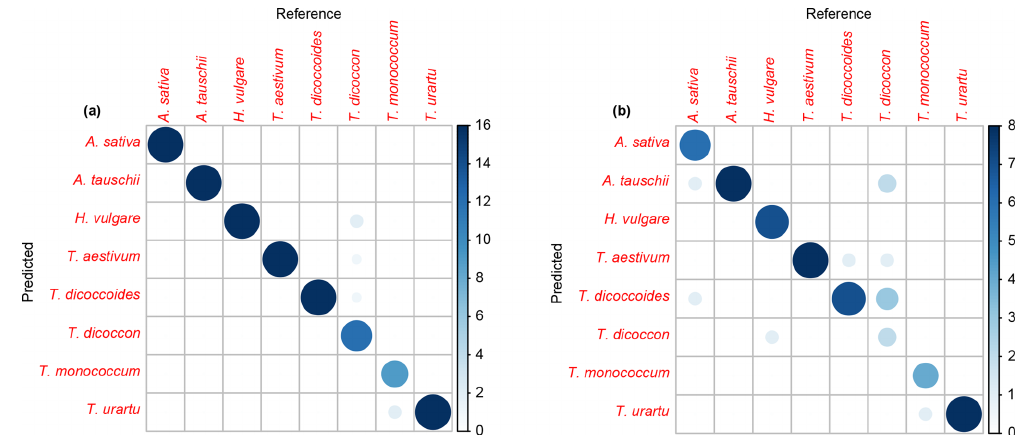
Figure 5. Confusion matrices for k -nn classification. (a) Training dataset and (b) validation dataset.